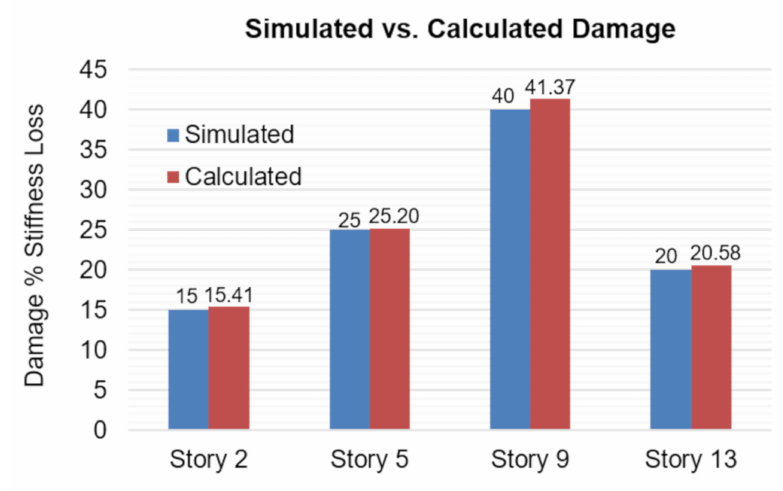
Figure 13. Comparison of prescribed and calculated damage levels.